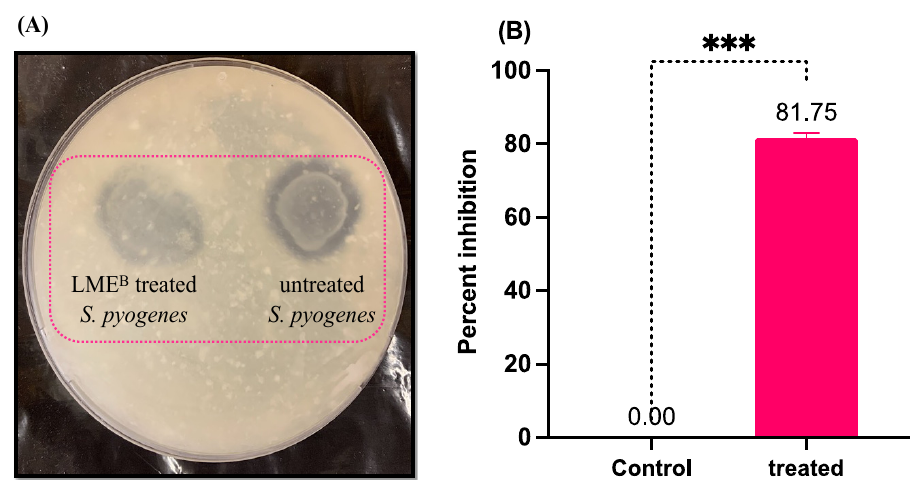
Figure 3. Effect of LME on extracellular protease production in S. pyogenes . ( A ) The picture shows the diminished zone of proteolysis around S. pyogenes growth in tryptose agar medium (1% skim milk) when treated with LME. ( B ) The percent inhibition of extracellular protease production in treated and untreated S. pyogenes . *** p value = 0.0001. The reduced protease production quantified by azocasein assay and lower enzymatic activity on a tryptose agar plate in LME-treated S. pyogenes further ascertained the capa- bility of LME to downregulate speB in S. pyogenes . The reduced activity and production of secreted streptococcal cysteine protease in treated S. pyogenes drastically reduced the